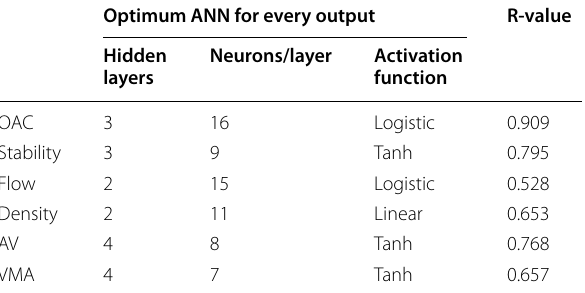
Table 13 The optimum ANN for every output Optimum ANN for every output